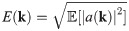
Kolmogorov flow—RMSE vs. time.Errors are computed for 104 test trajectories (legend: fully data-driven—green dashed; data-assisted—blue dashdotted; triad—orange dotted). The RMSE in each mode is normalized by the corresponding amplitude E(k)=E[|a(k)|2]. A test trajectory is classified as regular if |a(1, 0)| > 0.4 at t = 0 and rare otherwise. Performance for regular, rare and all trajectories are shown in three columns. Data-assisted model has very similar errors to those of purely data-driven models for regular trajectories, but the performance is visibly improved for rare events.